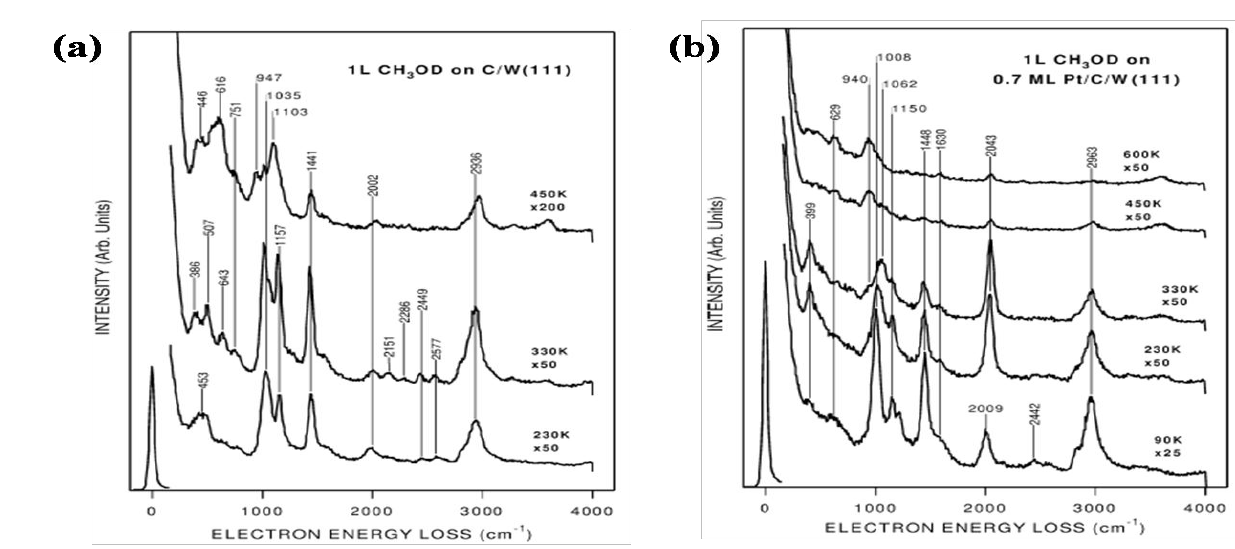
Figure 7. HREEL spectra monitoring thermal properties of 1.0 L CH pure C/W(111) and (b) 0.7 ML Pt / C / W(111). (Reprinted from Reference 88 with